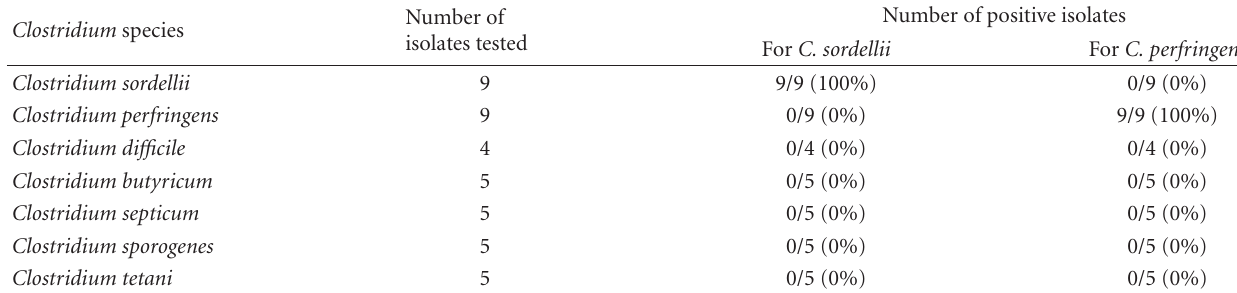
Table 3: Microsphere assay results of Clostridium species isolates.